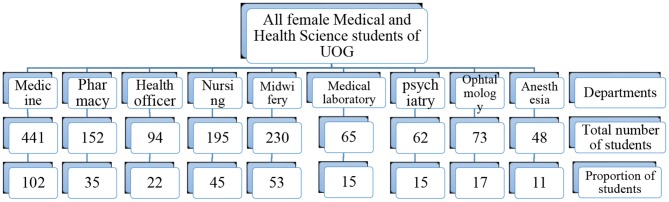
A flow chart describing the sampling technique, UOG, 2017.